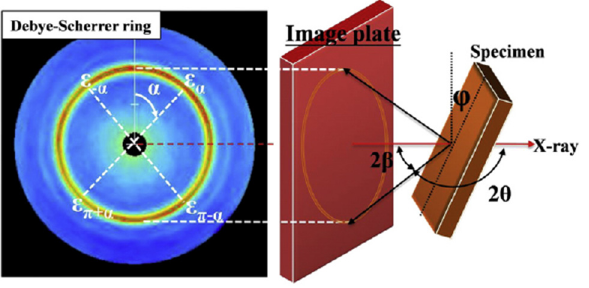
Figure 5. A schematic representation of the measurement of the Debye–Scherrer ring and the four types of strains used for stress calculation based on the cos α method [1].